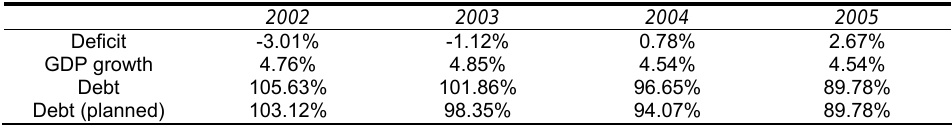
Table 11. Italian government deficit plan after a one-time deviation and revision